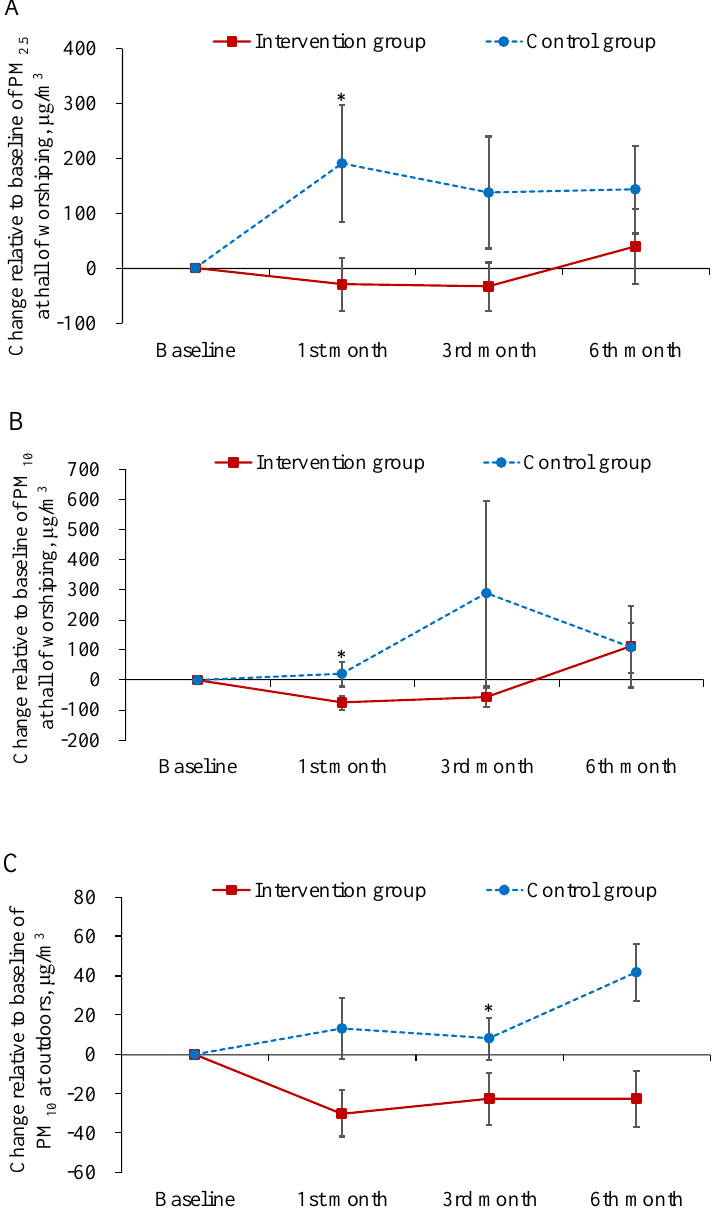
Figure 1. Mean di ff erence from baseline to post-test and its standard error of particulate matter at each follow-ups in the intervention and control groups. * indicated the di ff erence of the changed values from the baseline to a specific follow-up between the two groups was statistically significant. The improvement in knowledge regarding PM at the first- and third-month follow-up was greater in the experimental group than in the control group ( B = 2.73, 3.00; p < 0.001; Figure 2A). As greater improvement at the first-month follow-up than those in the control group ( B = − 2.16, − 1.54; p